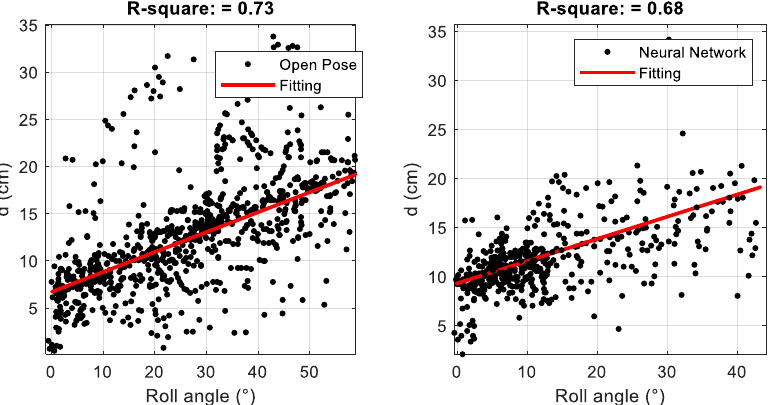
Figure 14. Correlation of roll angle vs. “ d ” with Fourier fitting curve: OpenPose ( a ) and neural network ( b ).